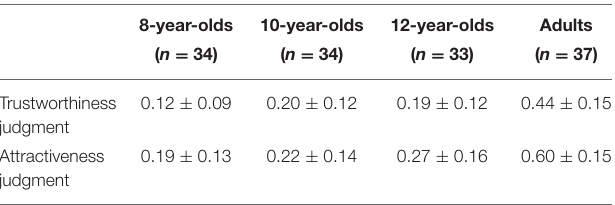
TABLE 2 | Descriptive statistics for the within-age agreements (Z-score) for facial judgments in each age group ( M ± SD )